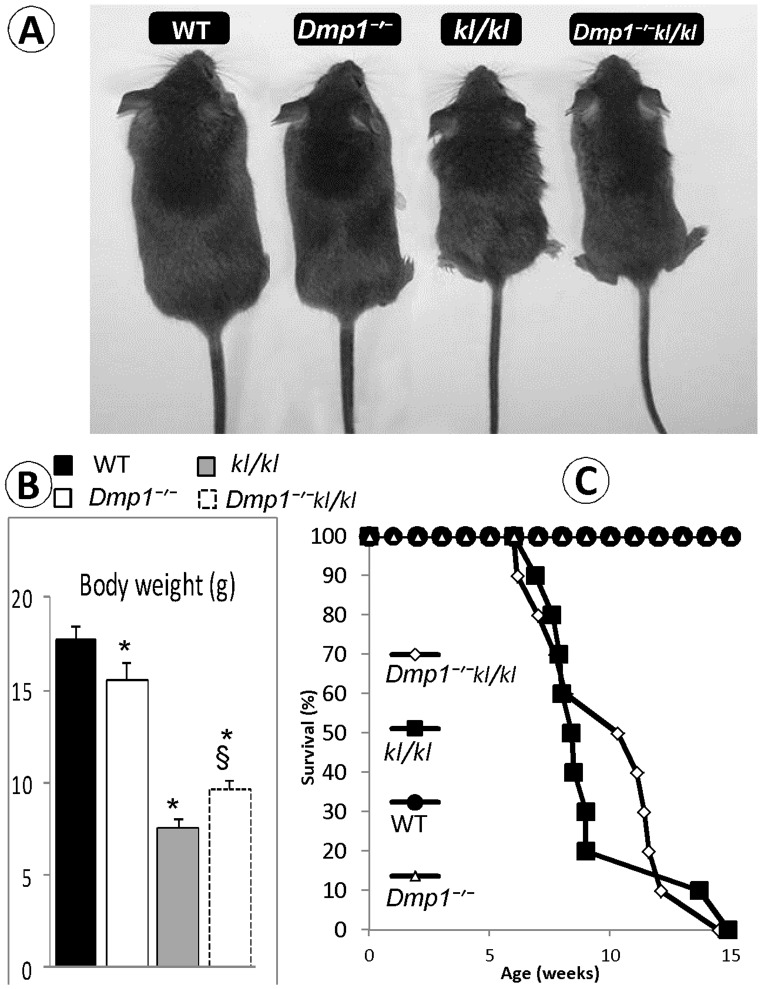
Macroscopic phenotype of Dmp1/Klotho compound deficient mice (Dmp1−/−kl/kl).(A) Gross appearance of Wild Type (WT), Dmp1 null (Dmp1−/−), Klotho deficient (kl/kl), and compound deficient (Dmp1−/−kl/kl) mice at 6 weeks of age. (B) Body weights of 6 weeks old mice, showing a decrease in Dmp1−/− (13%), kl/kl (57%) and Dmp1−/−kl/kl (36%) mice compared to the age matched WT (P = 0.02; P<0.001, and P<0.001 respectively; n = 10 in each group). Note that the Dmp1−/−kl/kl body weight was ∼ 30% higher than that of the single kl/kl mice (P = 0.03). (C) Survival for WT, Dmp1−/−, kl/kl, and Dmp1−/−kl/kl mice (n = 10 in each group). Both kl/kl and Dmp1−/−kl/kl mice showed similar low survival rate compared to WT and Dmp1−/− groups. About 40% of Dmp1−/−kl/kl animals survived 3 weeks more than single kl/kl. Neither of the kl/kl nor Dmp1−/−kl/kl groups survived more than 15 weeks. None of WT and Dmp1−/− animals died in 30 weeks of observation period. These mice were of similar genetic backgrounds but not necessarily littermates. *P<0.05 compared to WT; § P<0.05 compared to kl/kl.